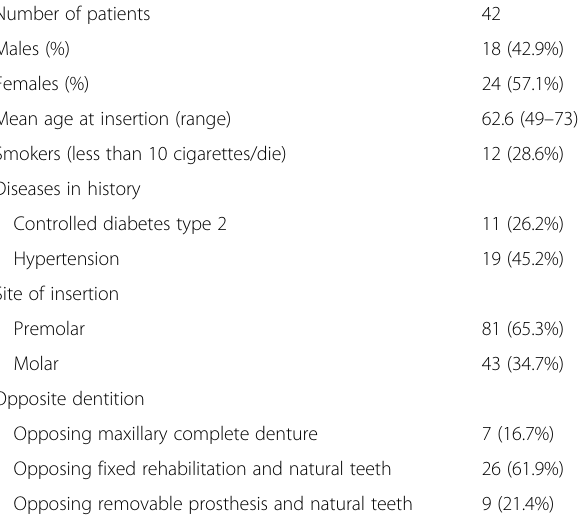
Table 1 Features of the subjects included in the study Number of patients